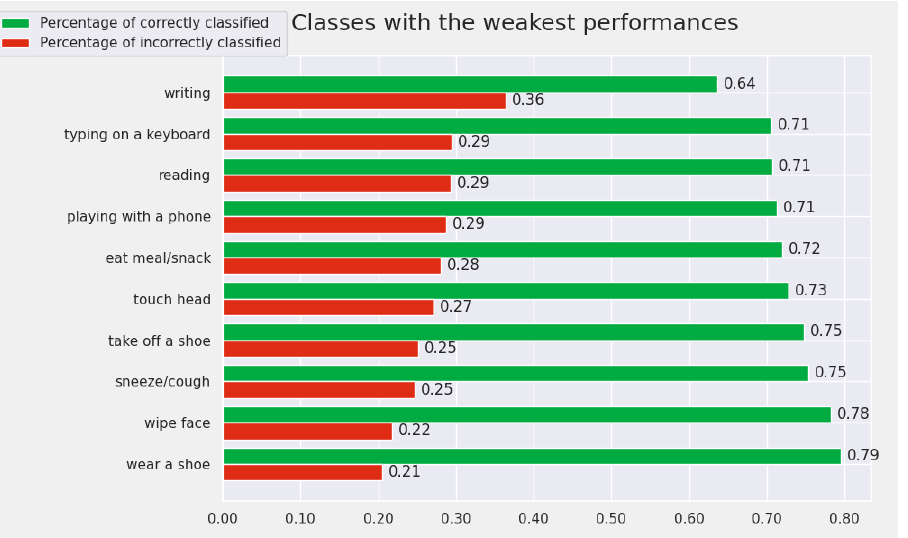
Figure 10. The Top 10 worst-recognized classes by the proposed model (from the perspective of Cross-Subject protocol).